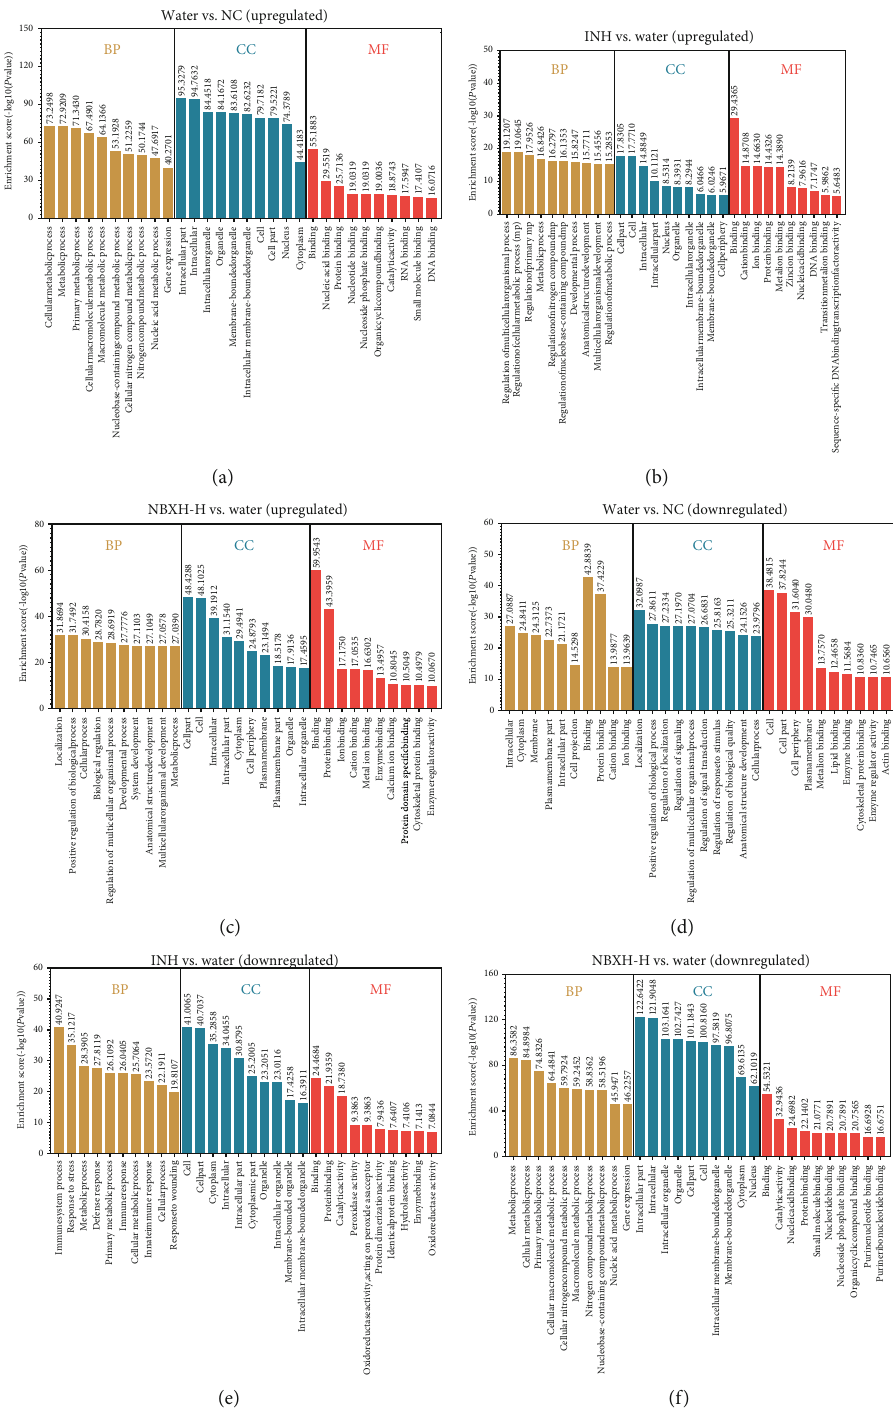
Figure 5: GO analysis of DE genes between before and after M. tuberculosis infection and INH or NBXH-H treatment. The top 10 GO terms involved in upregulated DE genes between TB-infected mice and normal mice ((a) Water vs. NC), between INH-treated mice and TB-infected mice ((b) INH vs. Water), or between NBXH-H-treated mice and TB-infected mice ((c) NBXH-H vs. Water) were, respectively, identi fi ed in BP, CC, and MF. Similarly, the top 10 GO terms involved in downregulated DE genes between the Water vs. NC groups (d), the INH vs. Water groups (e), or the NBXH-H vs. Water groups (f) were identi fi ed in BP, CC, and MF, respectively. The enrichment score is shown as -log10 ( P value); the P value denotes the signi fi cance of GO Term enrichment in the DE gene list. The less the P value is, the more signi fi cant of the GO Term is ( P ≤ 0 : 05 is recommended). BP: biological process; CC: cellular component; MF: molecular